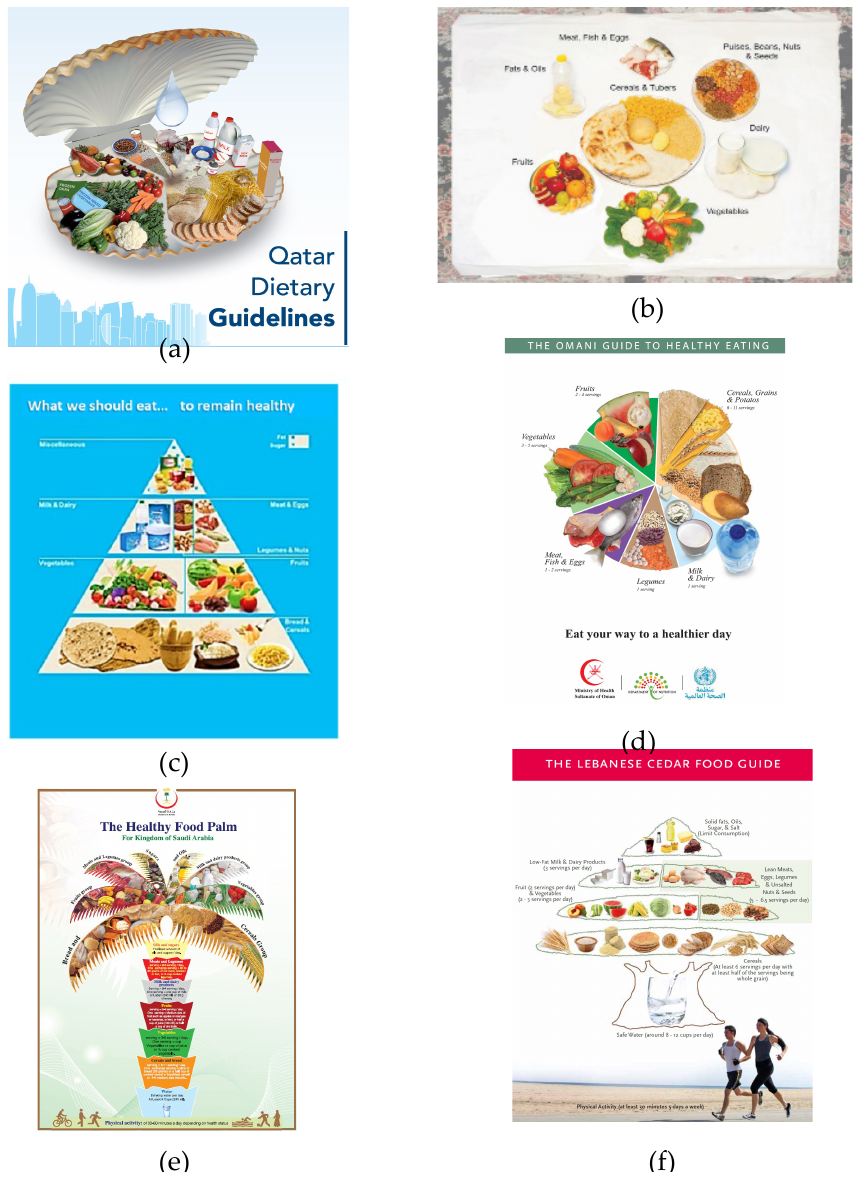
Figure 3. Food guide illustration shapes used for some Eastern Mediterranean FBDGs. ( a ) Qatar; ( b ) Afghanistan; ( c ) Iran; ( d ) Oman; ( e ) Kingdom of Saudi Arabia; ( f ) Lebanon.